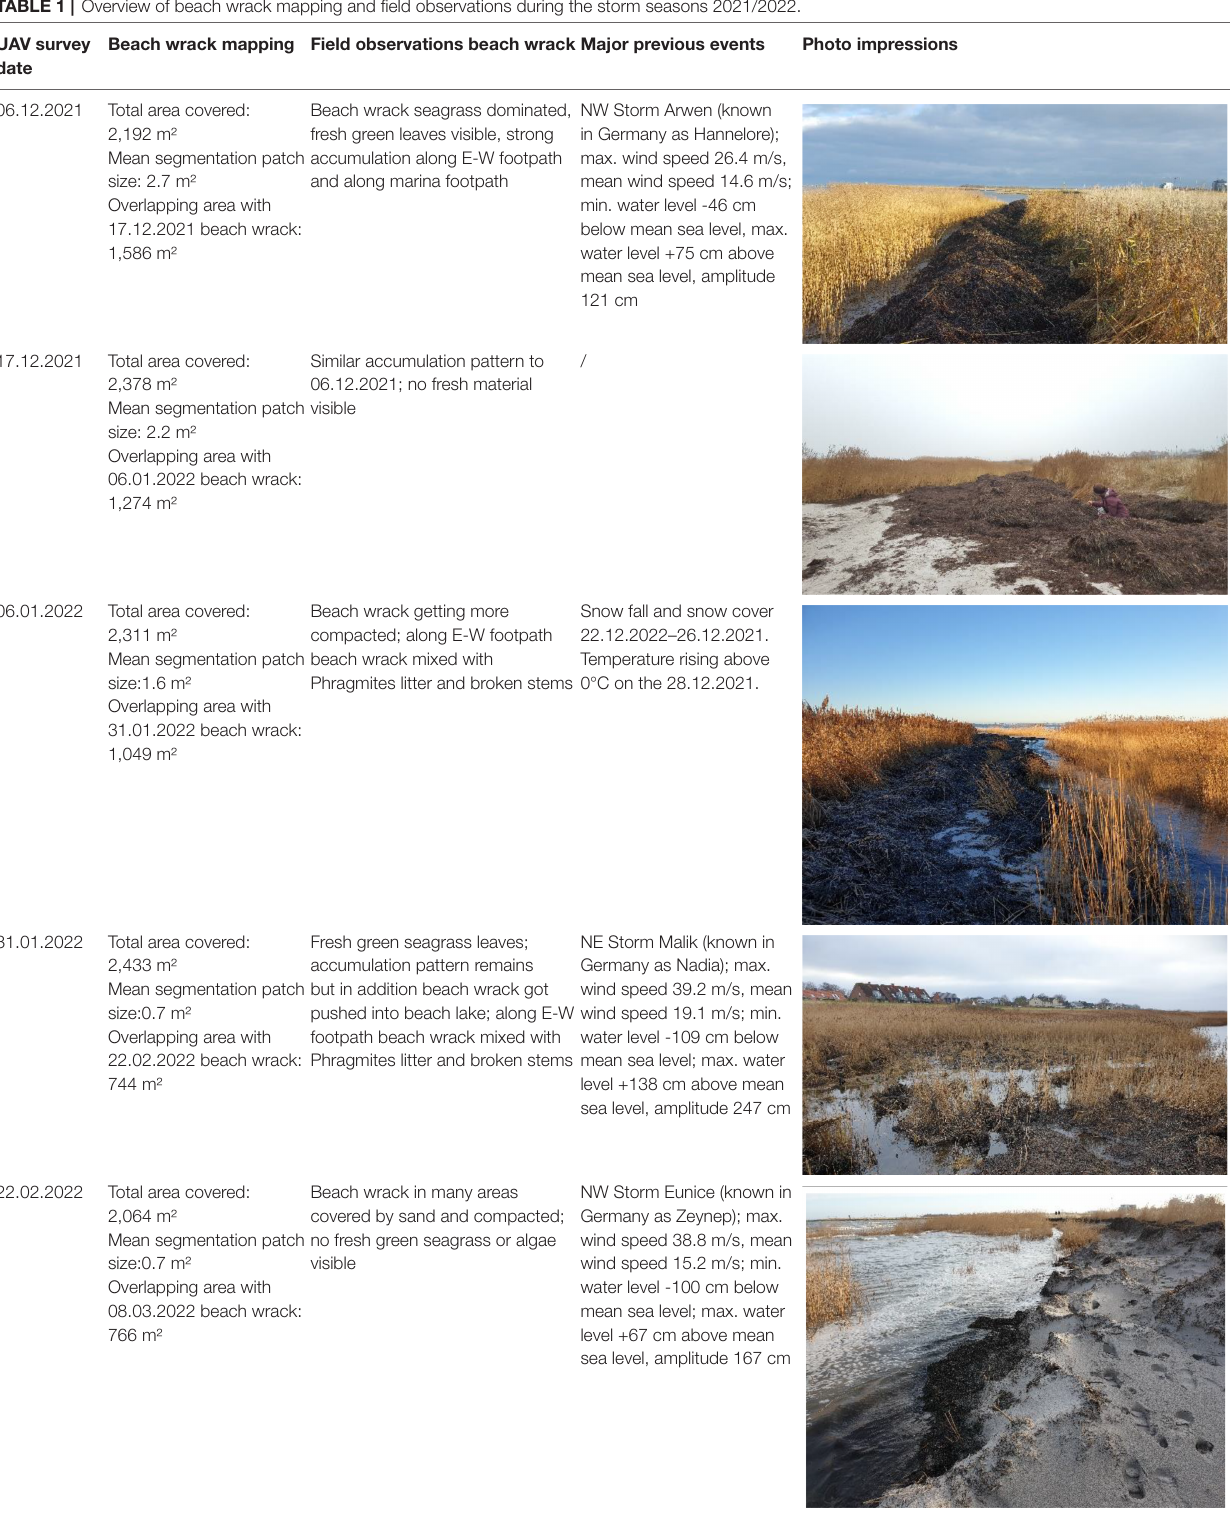
TABLE 1 | Overview of beach wrack mapping and field observations during the storm seasons